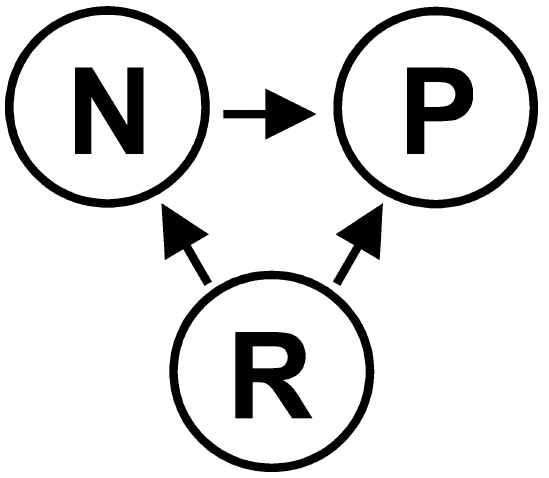
Fig. 1. The simple IGP system. P (top predators), N (intermedi- ate predators) and R (basal prey). The direction of the arrows indicates the energy flow (e.g. P eats